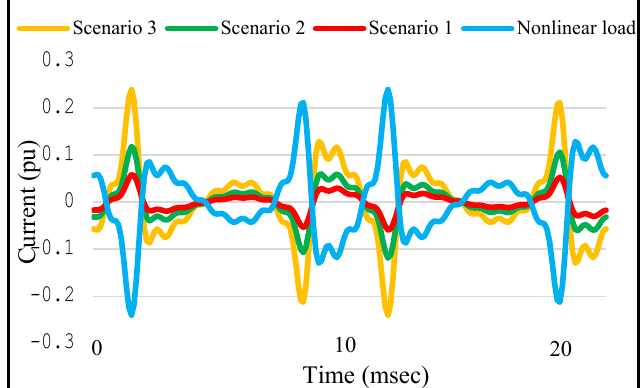
Figure 10. Current waveform of SACAPF compared to harmonic content of nonlinear load (scenarios are defined in Table 3).